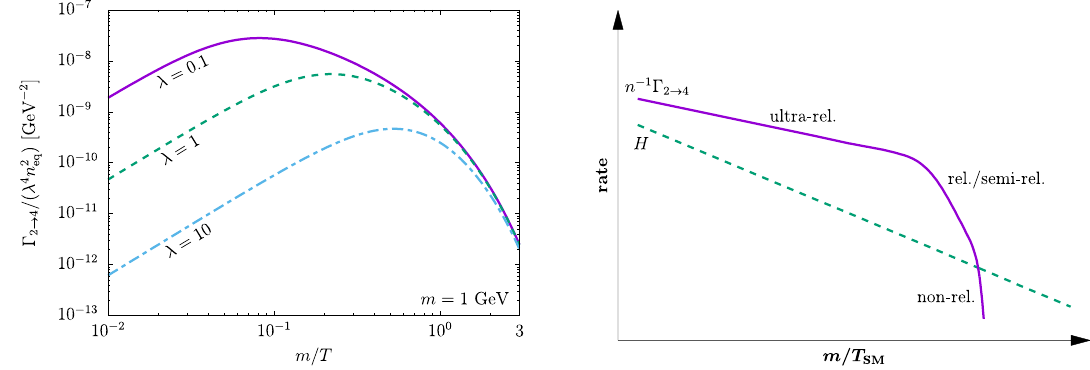
Figure 7 . Left: normalized 2 4 rate dependence on the coupling. The thermal mass effect is → clearly seen at m/T 1. Right: log-scale evolution of Γ 2 → 4 /n and H ≪